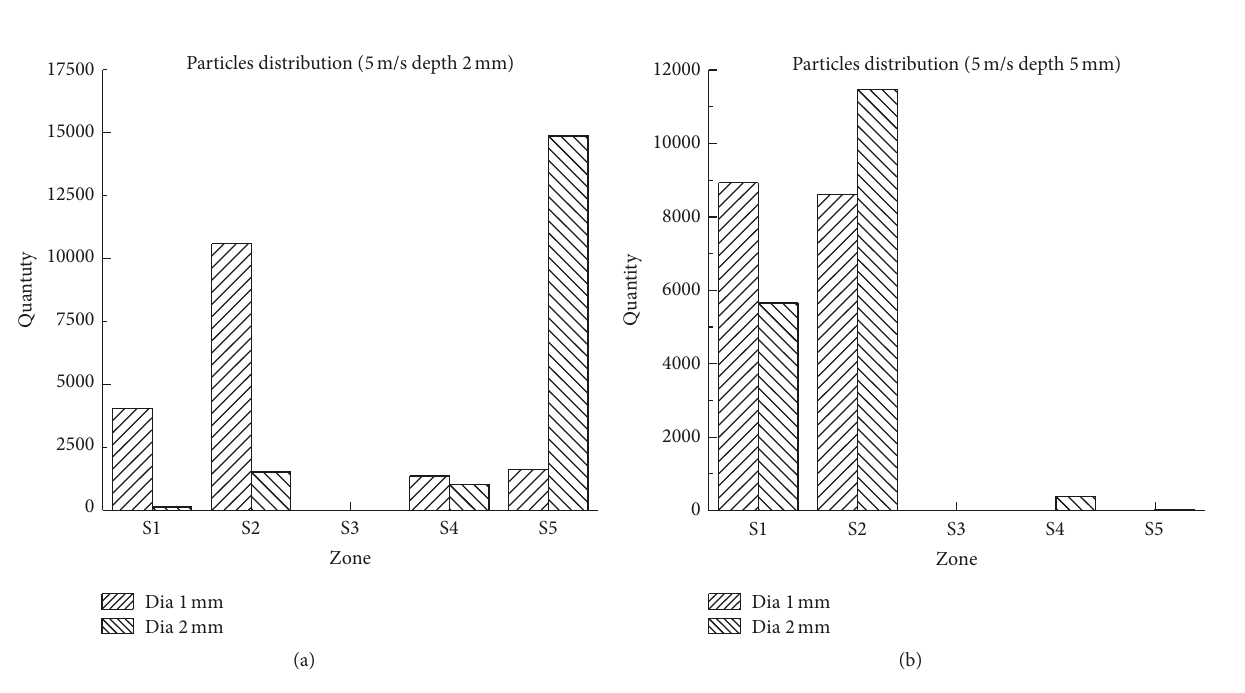
Figure 22: Impact of diameters on the debris